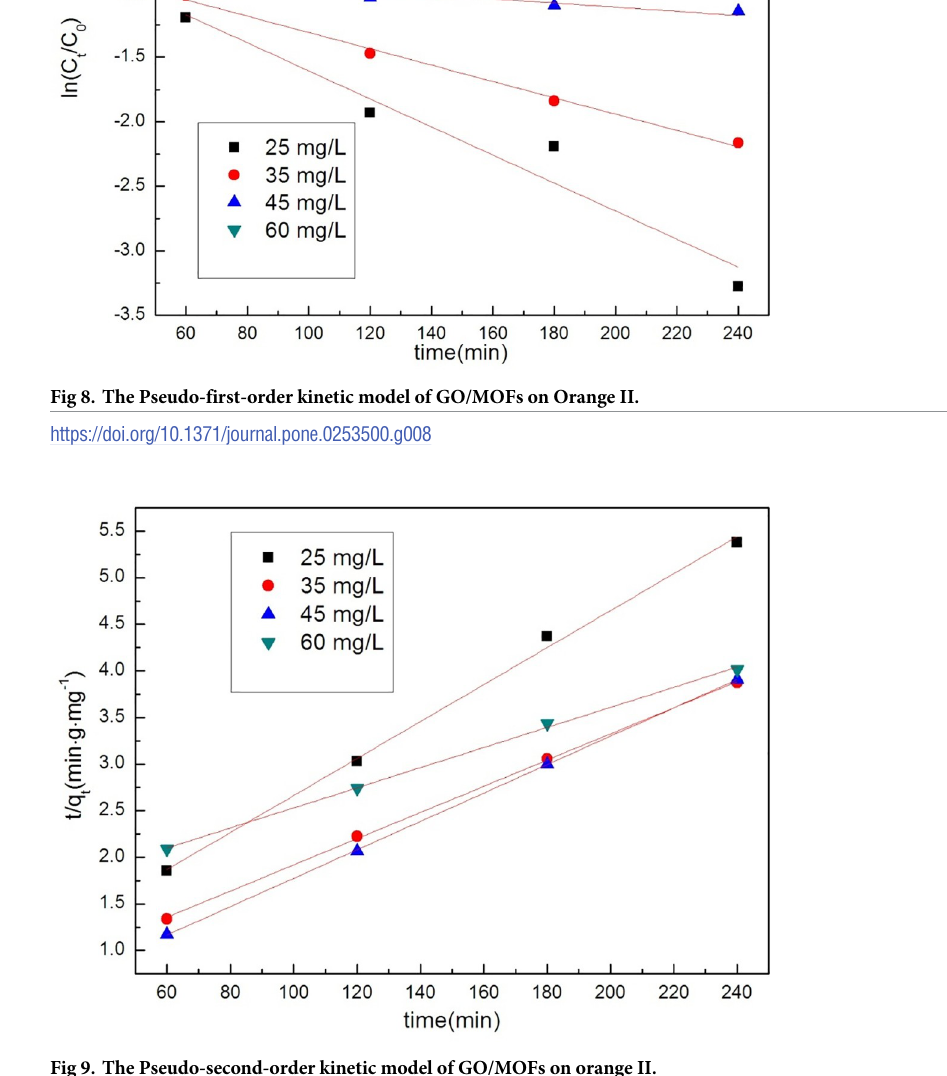
Fig 9. The Pseudo-second-order kinetic model of GO/MOFs on orange